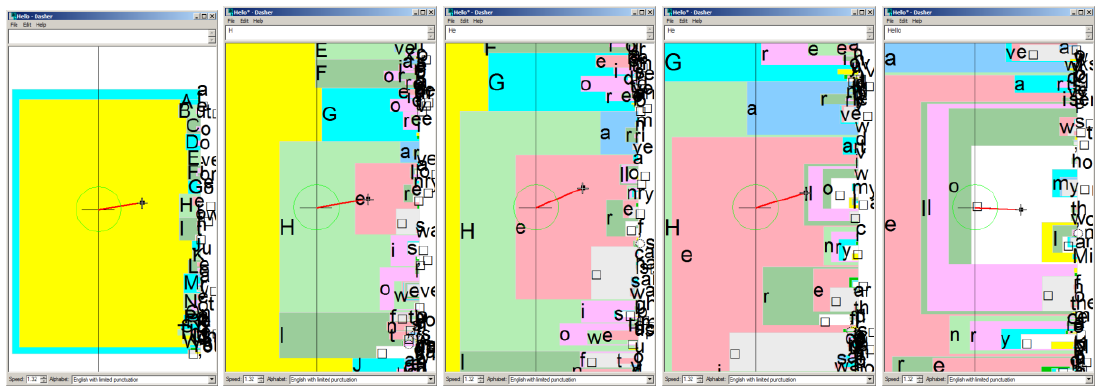
Figure 8. Five successive stages when entering ―Hello‖ with the Dasher